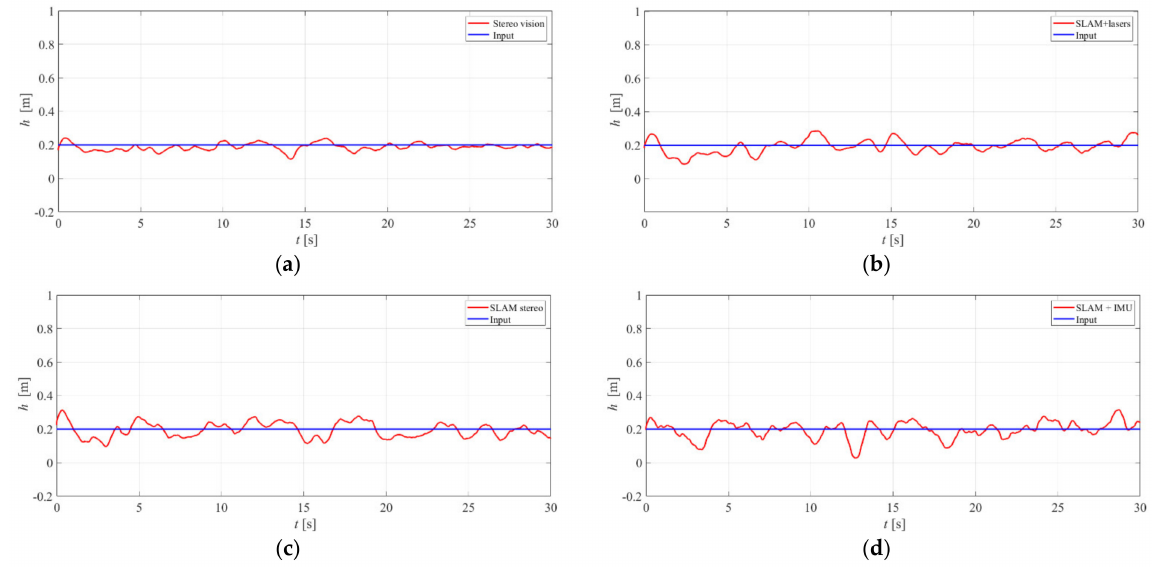
Figure 20. Distance-from-the-bottom control at a speed of 0.2 m/s: ( a ) stereo vision; ( b ) SLAM lasers; ( c ) SLAM stereo; ( d ) SLAM